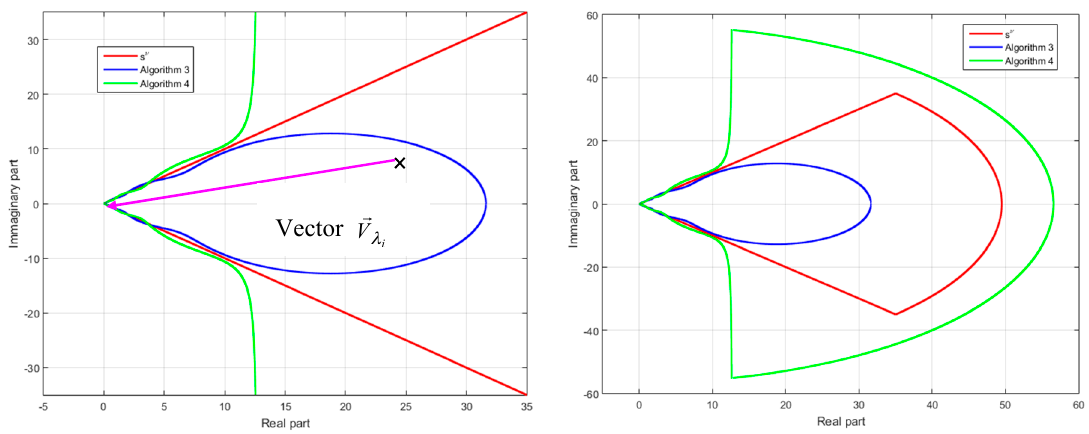
Figure 9. Considered path Г .